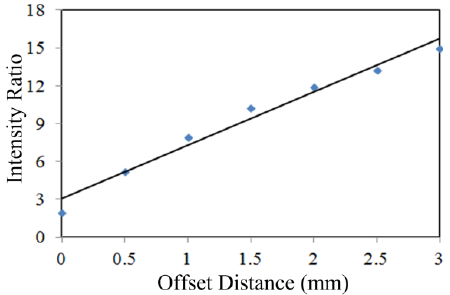
Figure 8. Ratio of Raman peak intensities at 1009 cm −1 (urea) and 644 cm −1 (capsule) for offset distance up to 3 mm on the three-layer capsule-urea sample.